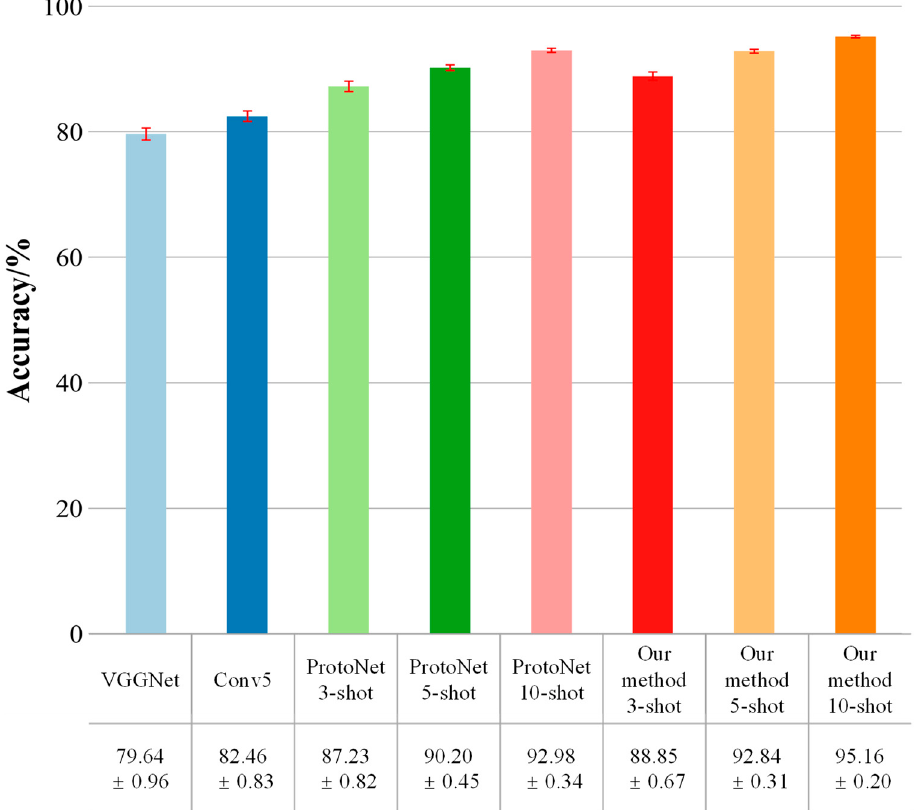
Figure 13. Accuracy (%) of identification of other models compared with the proposed model.